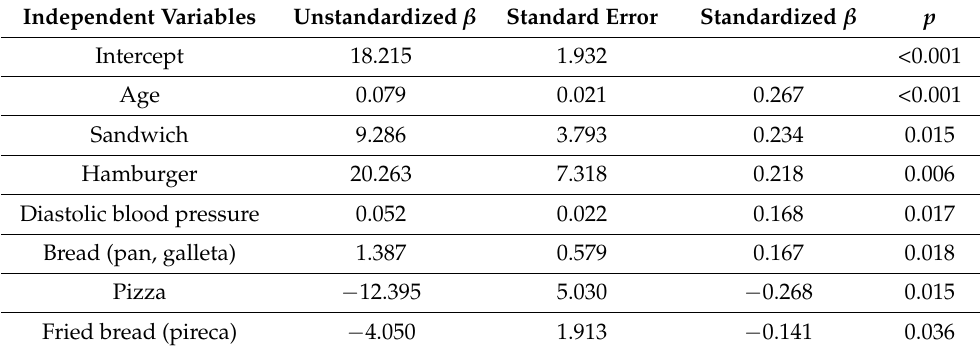
Table 3. Variables selected via best subset selection in multiple regression analyses for males. Independent Variables Unstandardized β Standard Error Standardized β